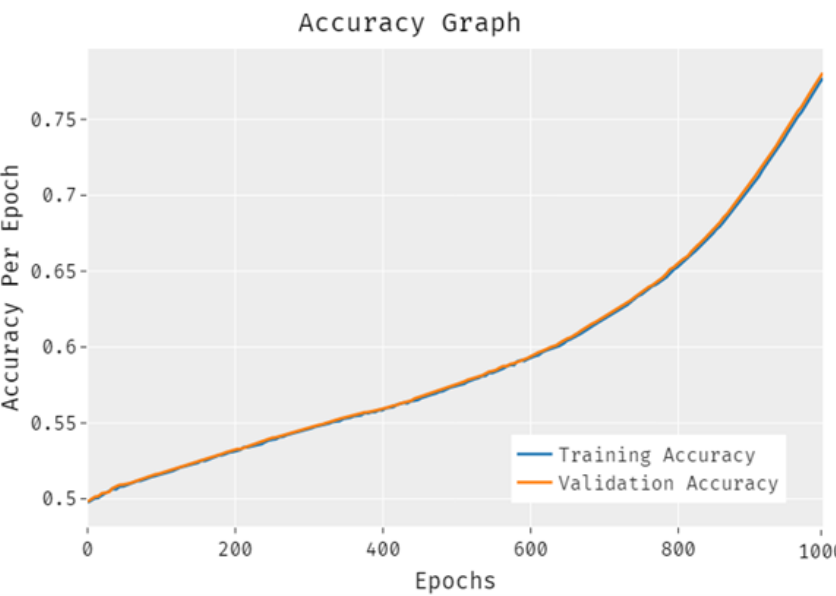
Figure 6. Accuracy analysis of ESOML-IDS technique under 1000 epochs.